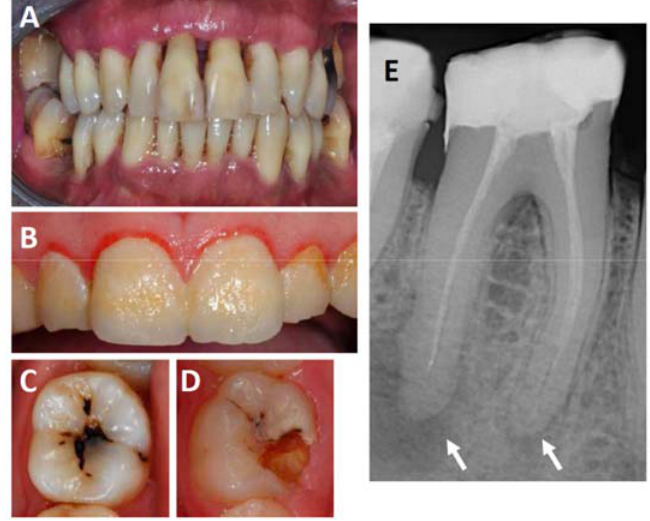
Figure 1. Frequent oral inflammations affecting the teeth, gingiva and the periodontium. ( A ) Shows